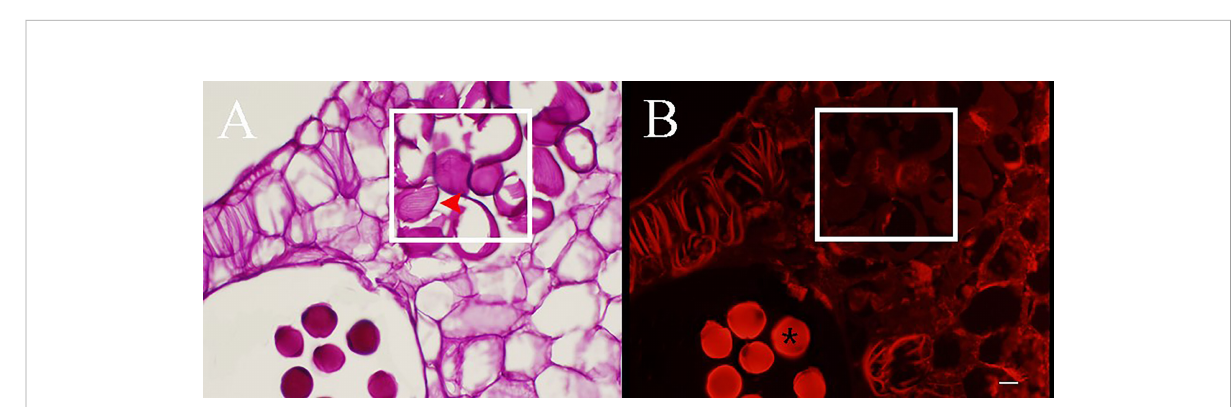
FIGURE 4 PAS staining sections of anthers during the development of pseudopollen of Camellia oleifera . (A) Obvious parallel ribs can be observed on the wall of pesudopollen grains (red arrow). (B) Under fl uorescence, the pseudopollen grains are black whereas the normal pollen grains are bright red (*). The white rectangle represents pseudopollen. Bar = 50 m